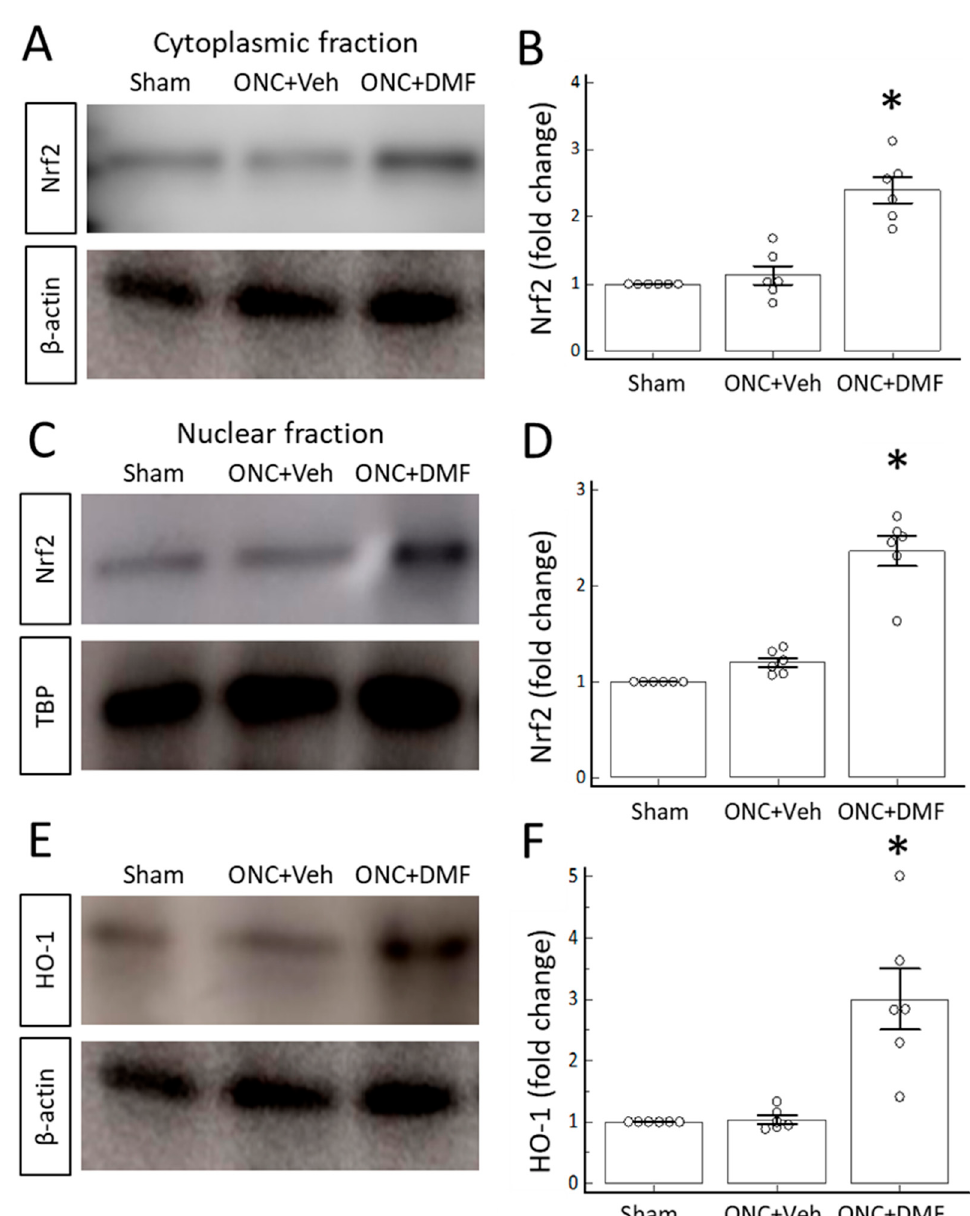
Figure 4. Western blotting analyses. ( A , B ) Nrf2 expression in cytoplasmic fractions extracted from retinal homogenates on day 7 after ONC with or without DMF: ( A ) representative blot; (B) quantitative comparison of the Nrf2/ β -actin ratio normalized by that of the sham operation without ONC. ( C,D ) Nrf2 expression in nuclear fractions: ( C ) representative blot image. ( D ) quantitative comparison of the Nrf2/TBP ratio normalized by that of the sham operation without ONC. ( E,F ) HO-1 expression in the retina on day 7 after ONC with or without DMF: ( E ) representative blot; ( F ) quantitative comparison of the HO-1/ β -actin ratio normalized by that of the sham operation without ONC. β -actin and TBP were used as internal controls. Each circle denotes the values of individual animals. Asterisks in all graphs indicate p < 0.05 ( n = 6, unpaired t -test).